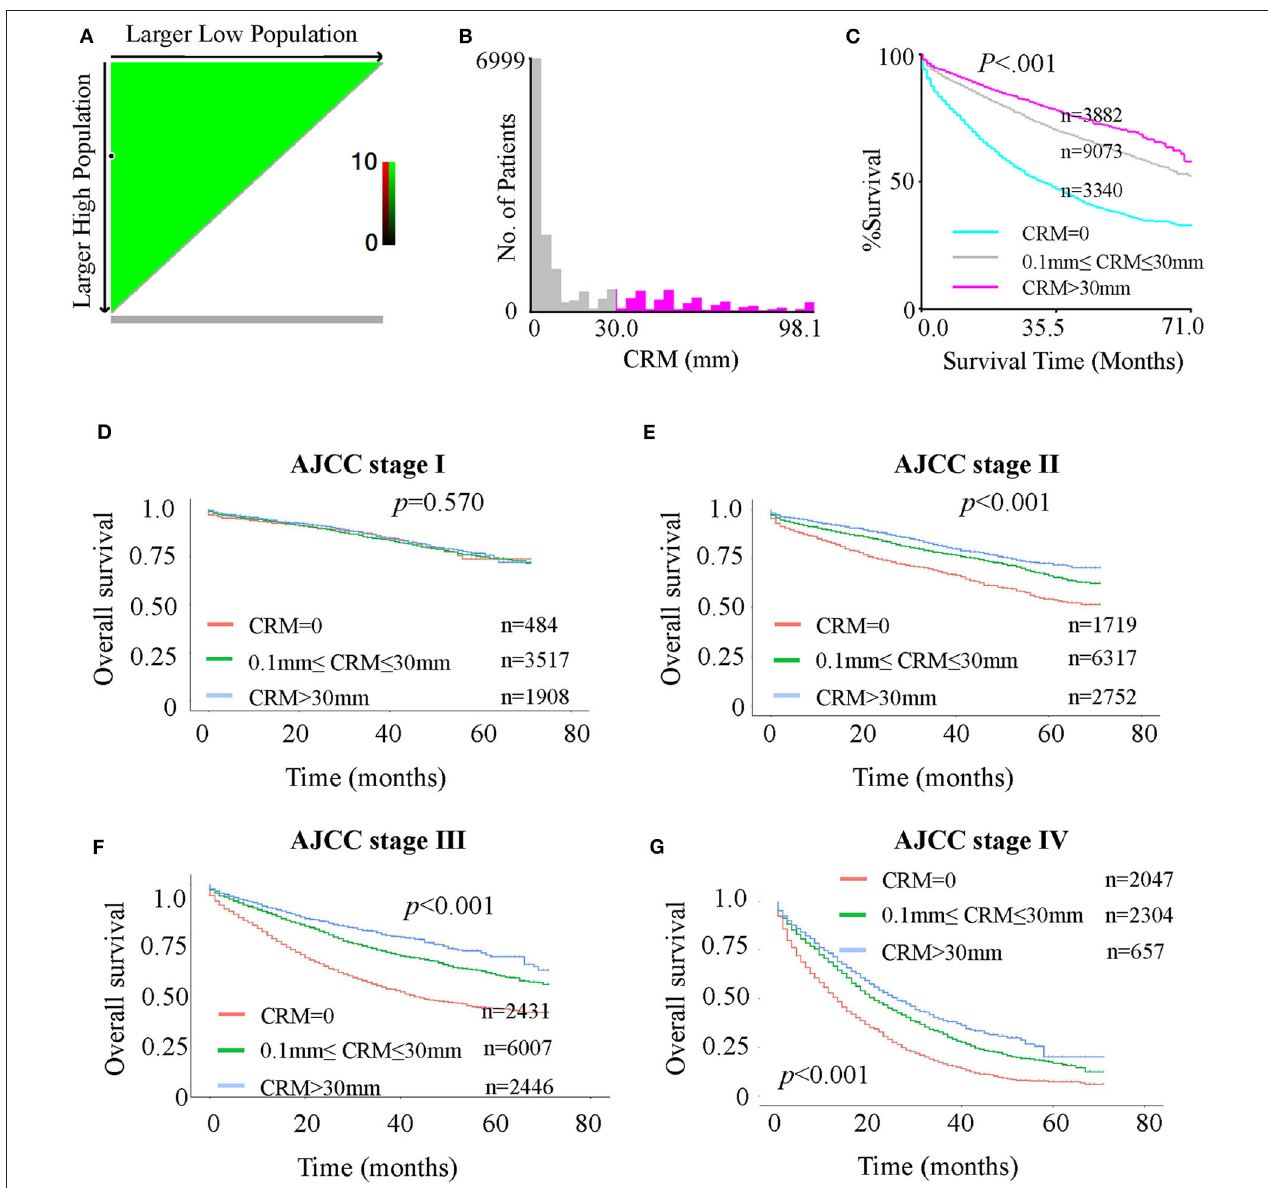
FIGURE 2 | (A-C): X-tile analysis of survival data for optimal CRM cutoff values from records of all patients. (A) Continuous direct association (colored in green) between increasing CRM values and improved survival, identifying 0 and 30mm as the optimal cutoff values using the minimum p -value method. (B) Distribution of CRM values among patients. (C) The minimal P -value determined by the optimal cutoff values of 0 and 30mm ( P < 0.0001). (D-G): Kaplan-Meier curves for OS in patients with different AJCC stages stratified by CRM records. (D) OS in stage I patients with CRM values of 0, 0–30, and > 30mm. (E) OS in stage II patients with CRM values 0mm, 0–30 and > 30mm. (F) OS in stage III patients with CRM values 0, 0–30, and > 30mm. (G) OS in stage IV patients with CRM values 0, 0–30, and > 30mm.